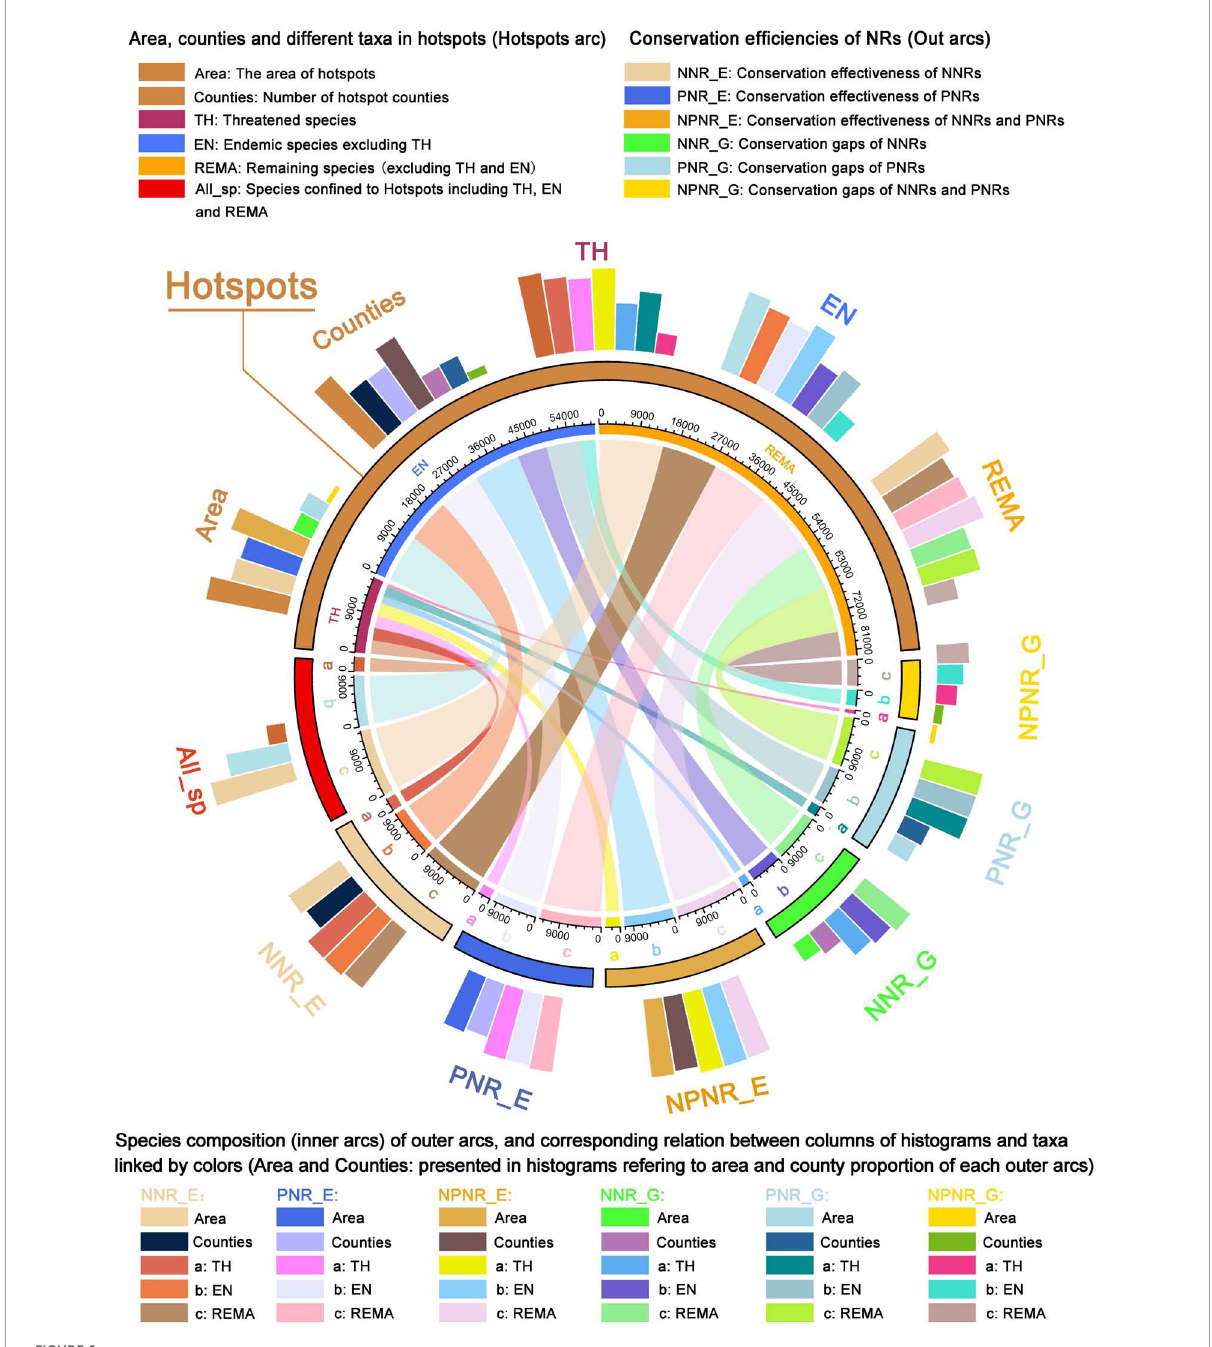
FIGURE6 Chord diagram and circular barplot showing the connections between the number and area of hotspot counties and species composition of seed plants in the hotspots, conservation effectiveness, and conservation gaps of NNRs and PNRs. The inner arcs are connected to the circular barplot of the same color to represent the same group. The colored fragments in the inner arc represent the number of species of a certain taxonomic group, or the aggregation of the hotspots, conservation effectiveness and conservation gaps of one taxonomic group. The ratio of the number of species of each taxon to the number of species of all species in hotspots is shown in